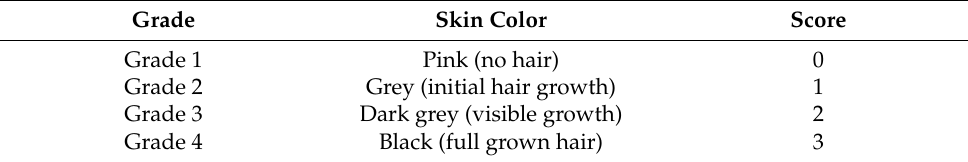
Table 1. Scores for 4 grades of skin